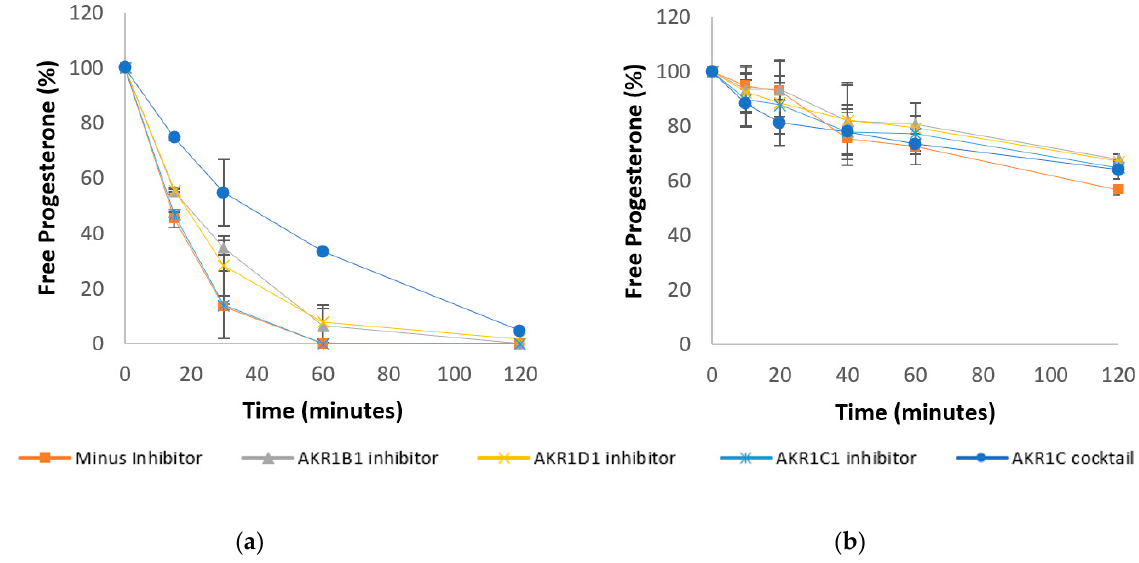
Figure 3. Stability profile of progesterone in human liver cytosol ( a ) and human intestinal cytosol ( b ) in the presence of 1mM of NADPH alone or with the addition of enzyme inhibitors (error bars are +/ − SD). Progesterone Clearance in Human Liver